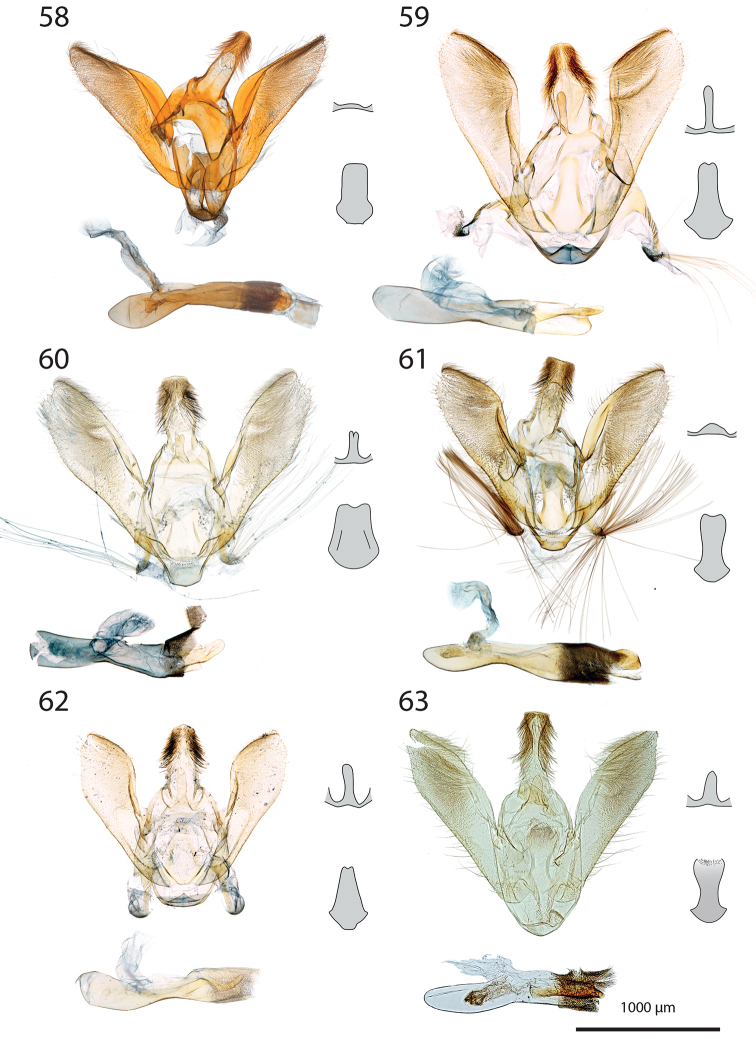
Male genitalia features of Hoploscopa. 58Hoploscopa
titika sp. nov., holotype, TL505 ♂ (apical part of juxta attached to phallus) 59Hoploscopa
pangrangoensis sp. nov., paratype, TL659 ♂ 60Hoploscopa
isarogensis sp. nov., paratype, TL762 ♂ 61Hoploscopa
ypsilon sp. nov., paratype, TL624 ♂ 62Hoploscopa
danaoensis sp. nov., holotype, TL632 ♂ 63Hoploscopa
quadripuncta, holotype, Pyralidae Brit. Mus. Slide N° BMNH20257 ♂.